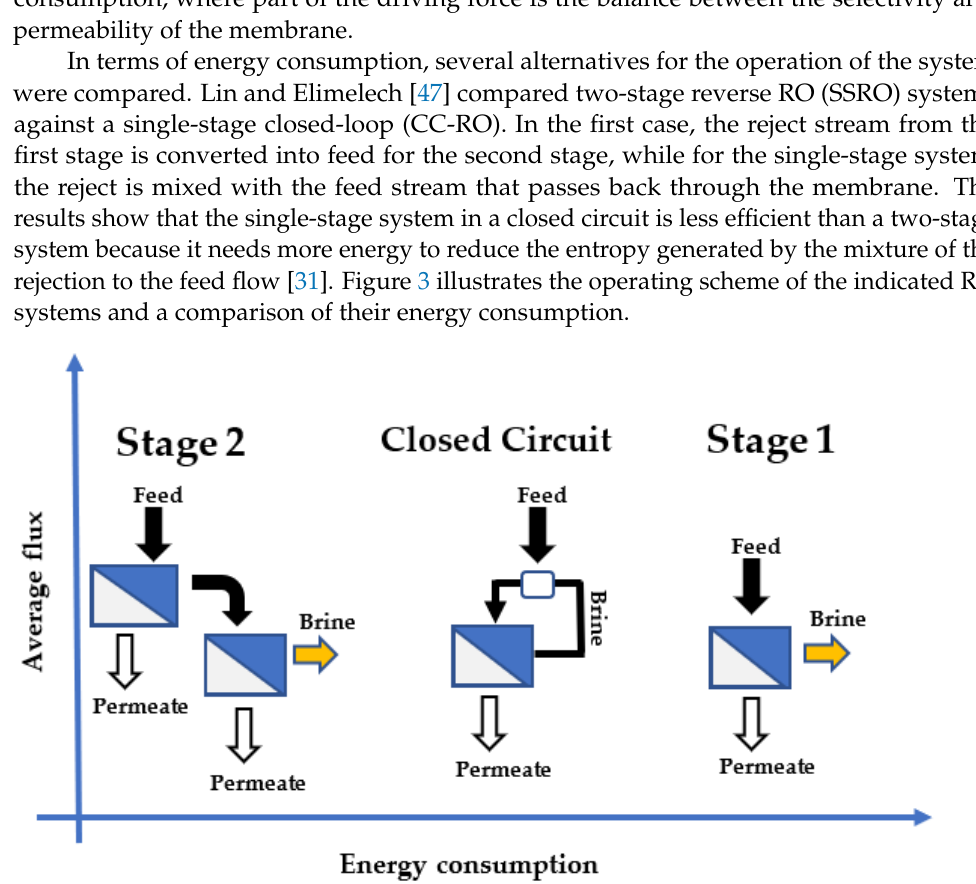
Figure 3. Energy consumption in one-stage, two-stage, and closed-loop RO systems, source [31].